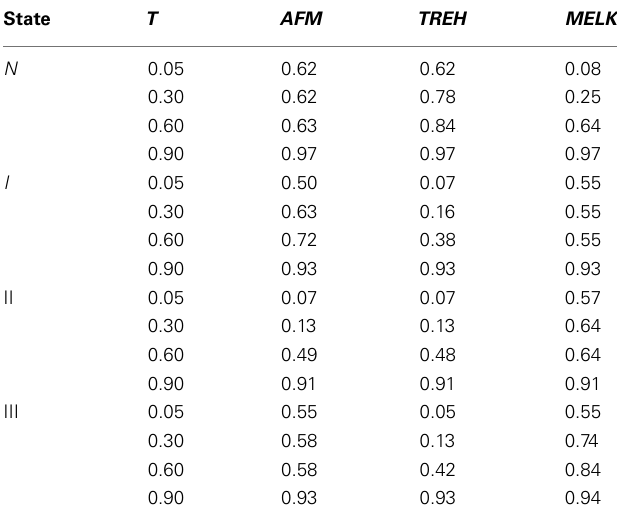
Table 4 | List representative genes of renal cancer which have big difference in the size of cascading failure in different networks.